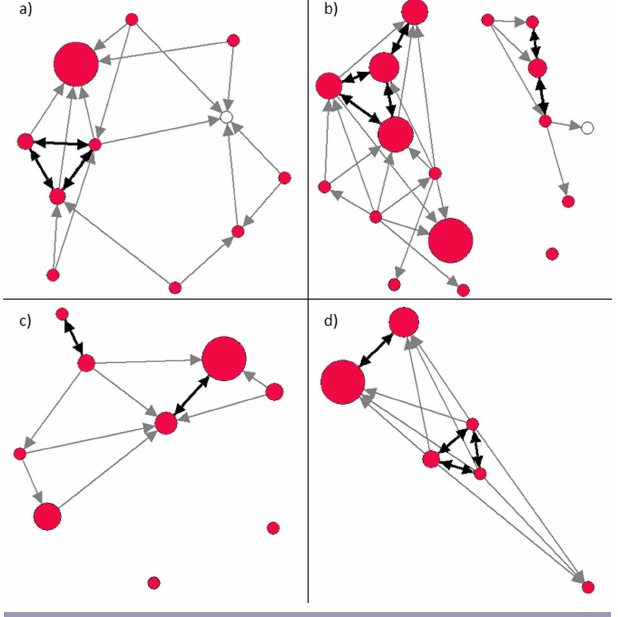
Fig. 2 . Social network diagrams showing information-sharing ties in (a) Blyth, (b) Amble, (c) Seahouses, and (d) Holy Island. Circles (nodes) represent fishers. Red circles represent fishers interviewed; unshaded circles indicate fishers not interviewed. Adjacent labels represent fisher identification numbers, and circle size represents the number of times a fisher was named as successful by peers. Arrows and lines indicate direction of communication flow. Black lines indicate reciprocal flow; gray lines indicate unreciprocated flow. Graph layout is based on multidimensional scaling